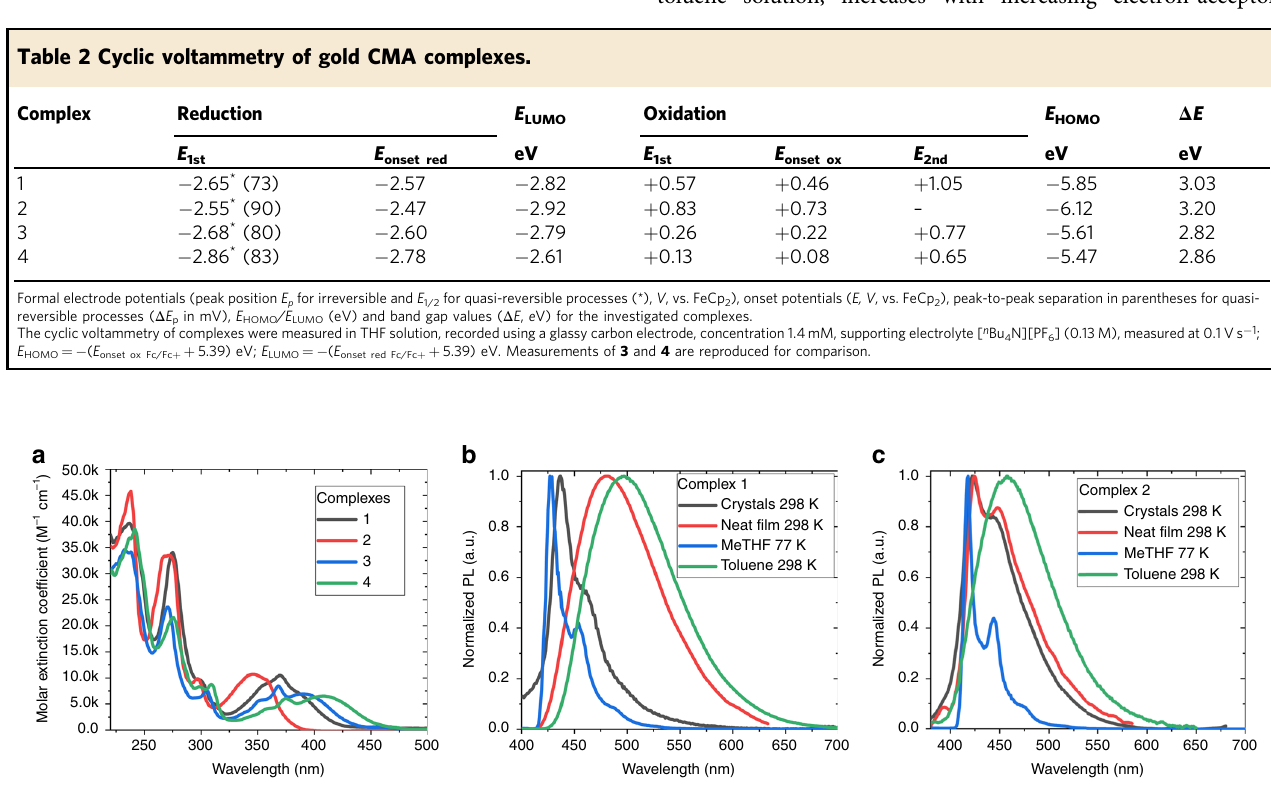
Fig. 2 UV – vis and photoluminescence spectra of gold CMA complexes. a UV – vis spectra in THF solution for gold complexes 1 , 2 in comparison with 3 and 4 . Photoluminescence spectra of 1 ( b ) and 2 ( c ) at 298 K as crystals, in neat fi lm, in frozen MeTHF and in liquid toluene solution (excitation at 365